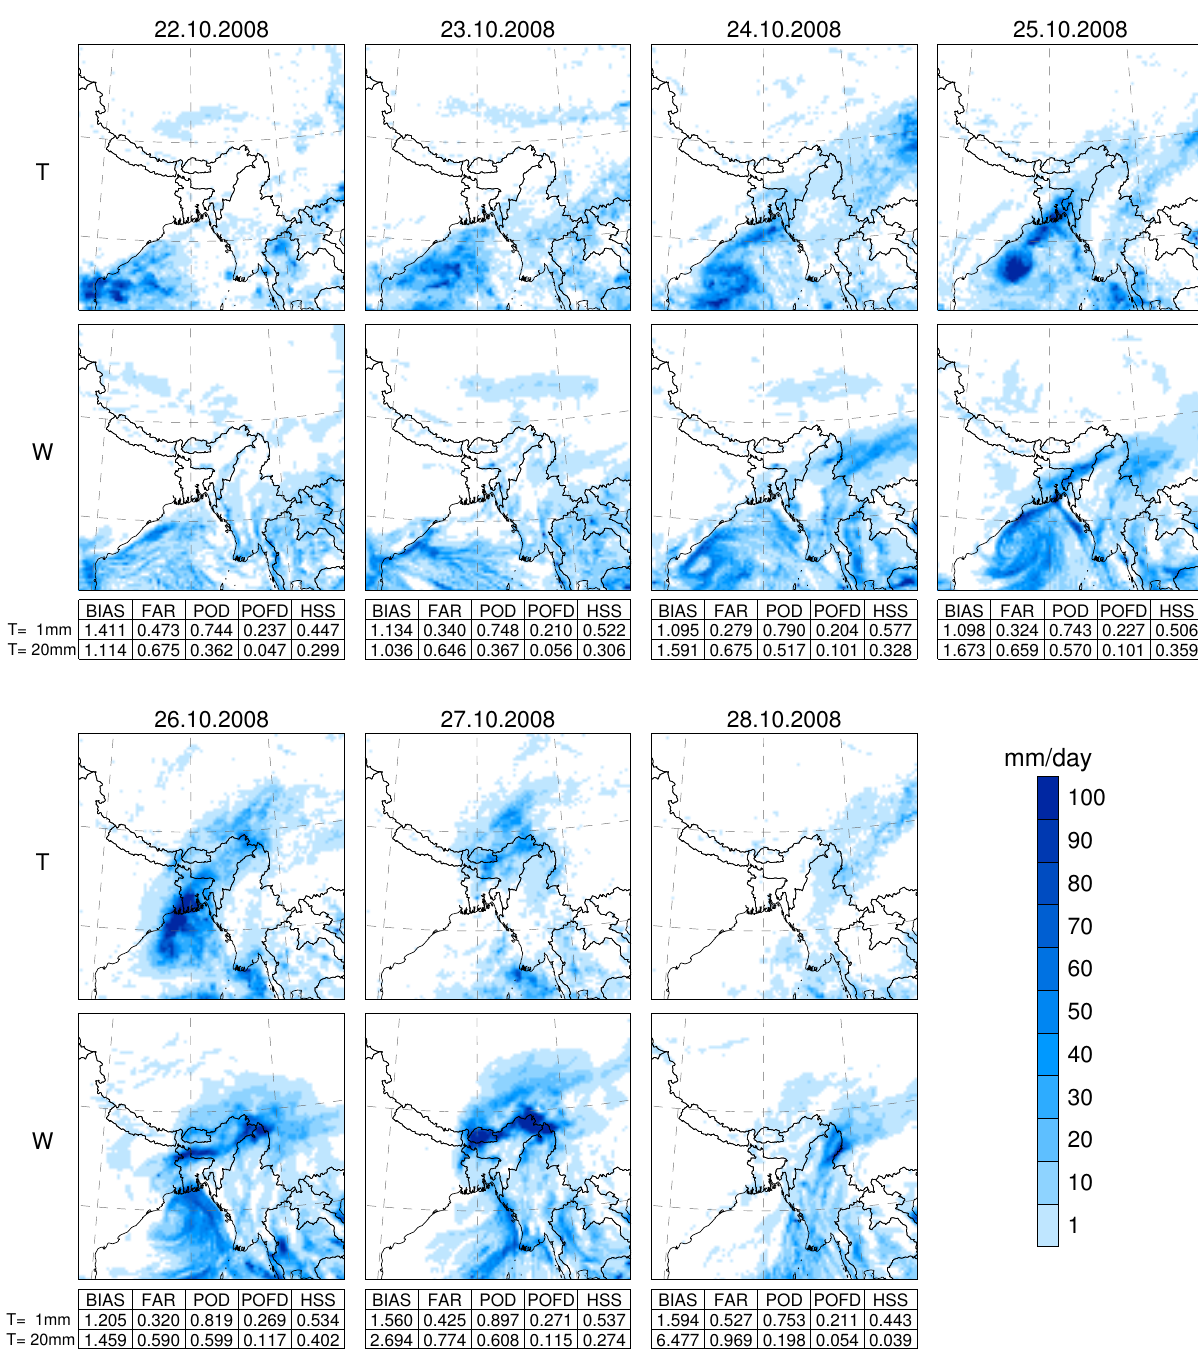
Fig. 4. Daily precipitation fields (mm/day) from (T) TRMM and (W) WRF30 over a subset of the LD for the period 22 to 28 October 2008.